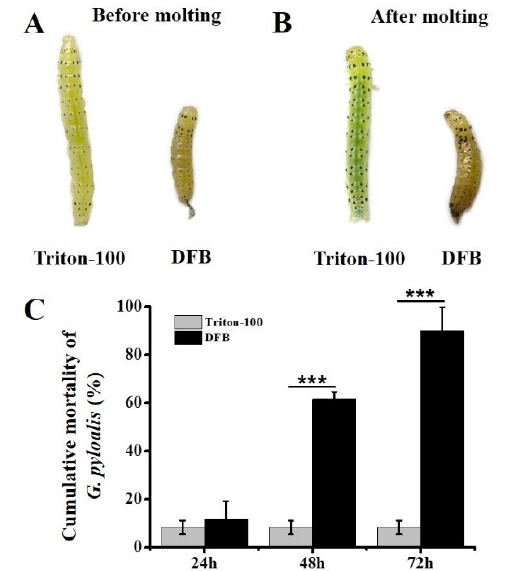
Figure 9. The e ff ect of DFB on G. pyloalis development. ( A - B ) G. pyloalis phenotypes post-DFB and Triton-100 (control) treatment before and after molting. ( C ) Cumulative mortality of G. pyloalis after exposure to DFB and Triton-100. Di ff erences among triple repeats were analyzed using one-way analysis of variance (Systat, Inc., Evanston, IL) with Tukey’s post-hoc test using R version 4.0.0. Asterisks represent the significant di ff erence, as follows: *** p < 0 .001.